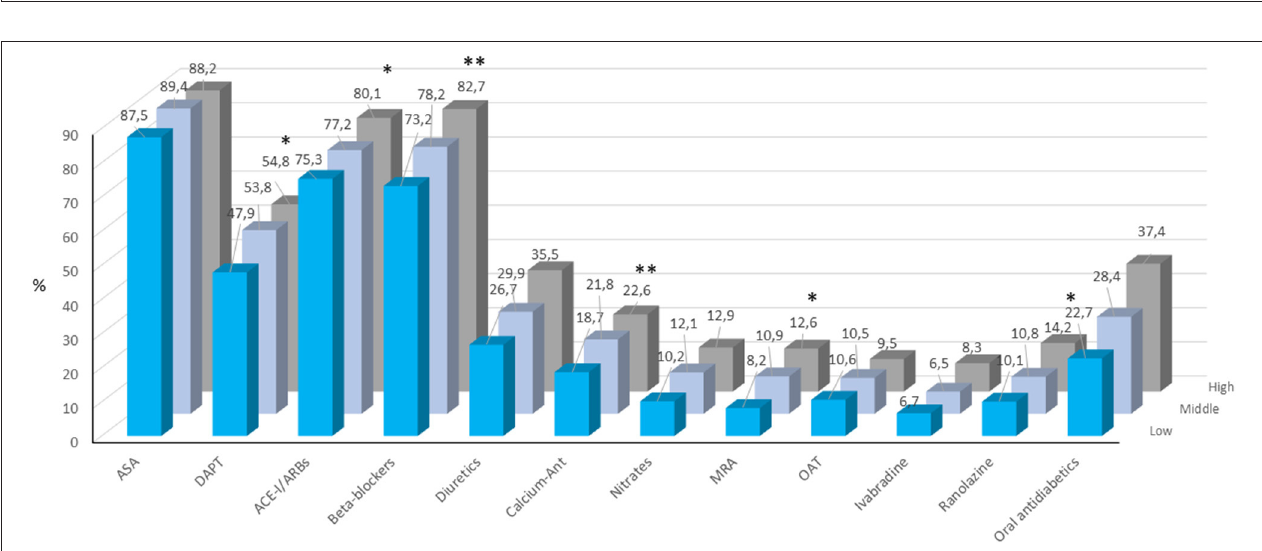
FIGURE 1 | Associations of lipid lowering strategies according to tertiles of TG/HDL ratio. Other possible combinations not shown were used in < 0.5% of cases.